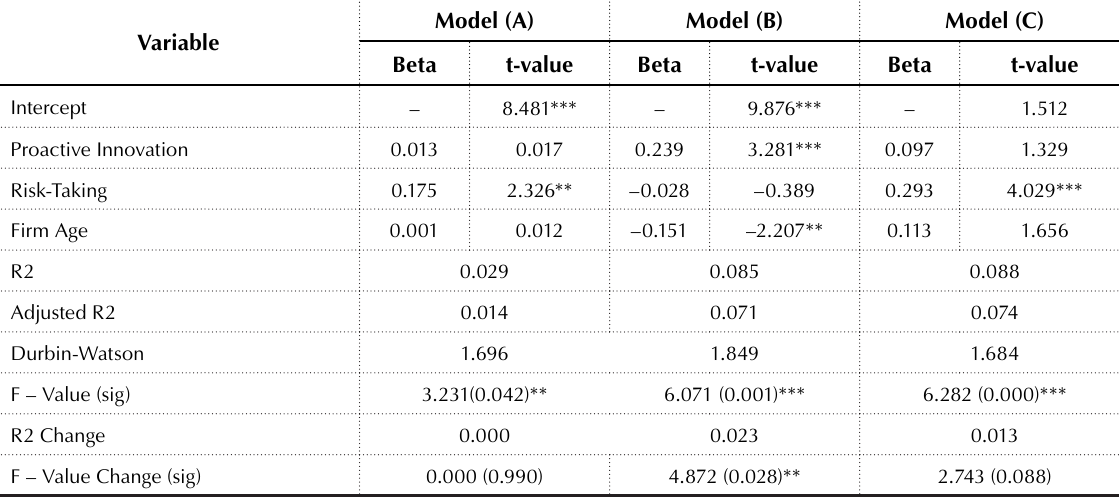
Table 3. Regression analysis of EO dimension constructs and firm